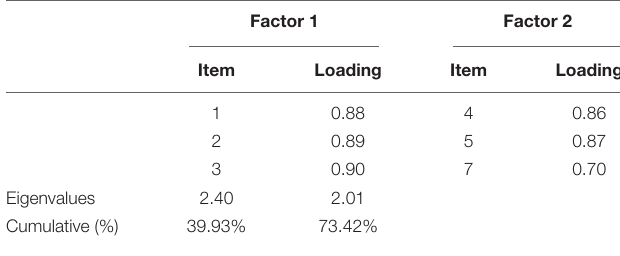
TABLE 3 | Results of EFA of the CINL Scale after